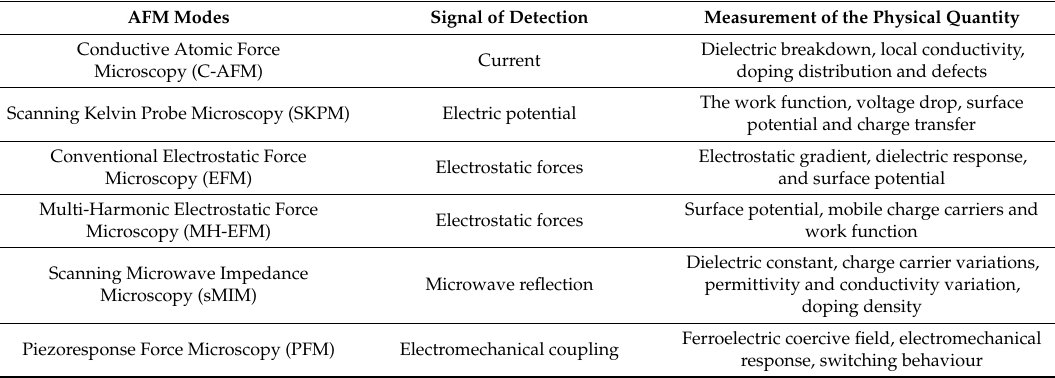
Table 2. AFM techniques and their applications (reprinted with permission from [202]).